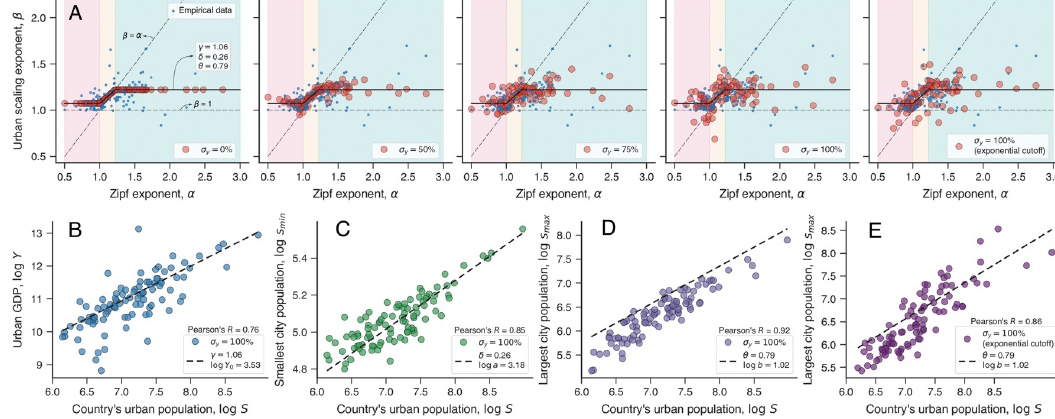
Fig 3. Simulating the connection between α and β , and the country scaling relationships. (A) Simulated relationships between α and β under different levels of random variation in the urban scaling law (Eq 2). Here σ is the percentage of the standard deviation in y the empirical values of β . We have a perfect agreement between simulations and the model of Eq (9) when σ y = 0%, and the results become very similar to the empirical data (small blue dots) as the intensity of the random variation increases. (B)-(D) Simulated country scaling laws for σ y = 100%. The dashed lines represent the scaling relationships of Eqs (5), (6) and (8), with parameters estimated from empirical data. We notice that the simulated scaling laws of total urban GDP ( Y ) and smallest city population ( s min ) follow well the empirically adjusted relationships, while the simulated values for the largest city population ( s max ) underestimate the empirical values. This occurs because large populations are rare and do not get close enough to the imposed maximum s max . (E) Scaling relationship between s max and S when considering that city population values are drawn from a power-law distribution with exponential cutoff. We notice this change makes the simulated results very similar to the empirical ones. The right-most plot in panel A shows a simulated relation between β and α when considering the exponential